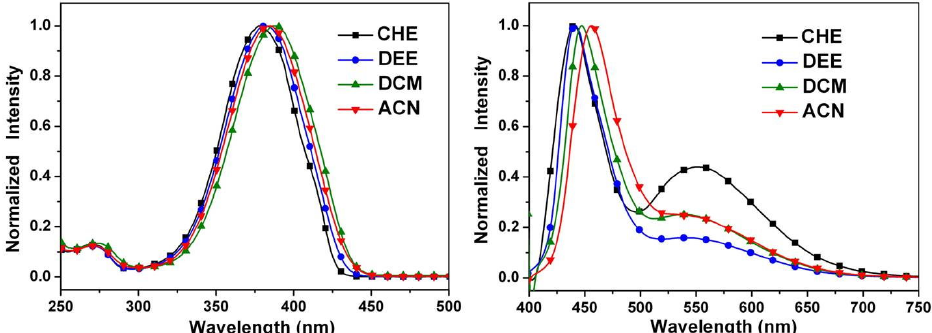
Figure 7. Normalized absorption ( left ) and emission ( right ) spectra of 4 in cyclohexane (CHE), diethyl ether (DEE), dichloromethane (DCM), and acetonitrile